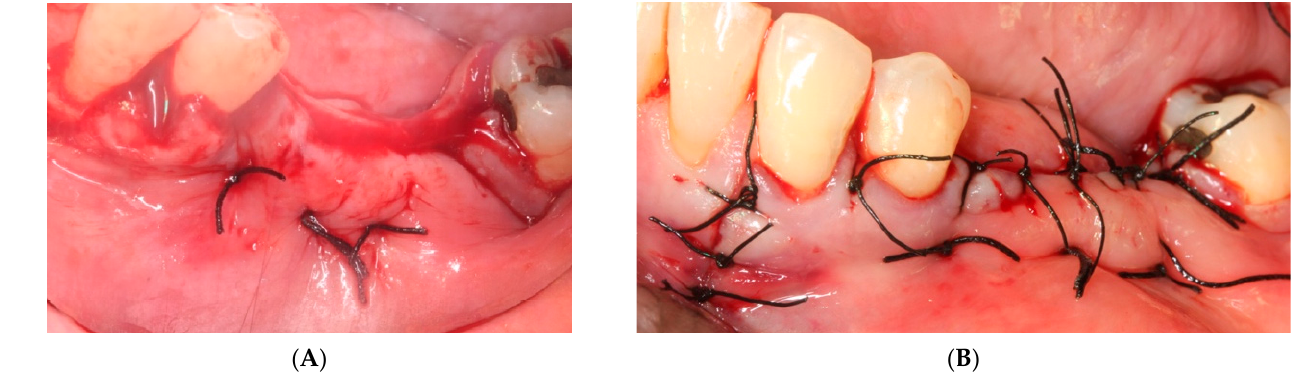
Figure 6. ( A ) Horizontal mattresses to evert the edges. ( B ) Simple Interrupted Suture.